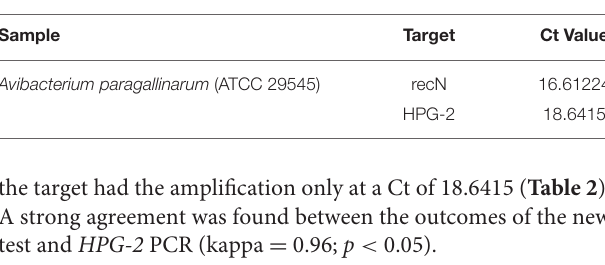
TABLE 2 | Ct values for recN and HPG-2 targeted